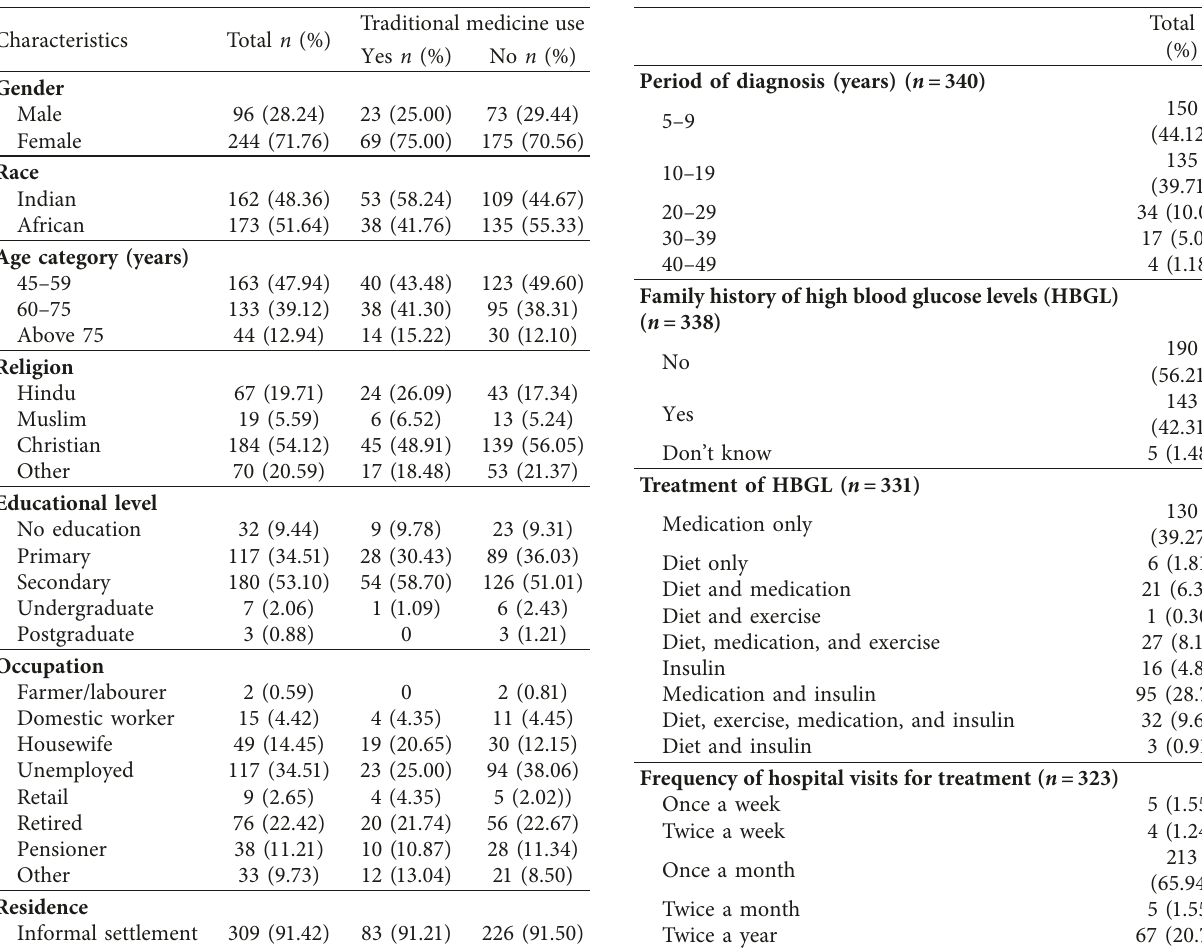
Table 2: Clinical characterization and self-care activities among type 2 diabetes mellitus patients ( N � 340).